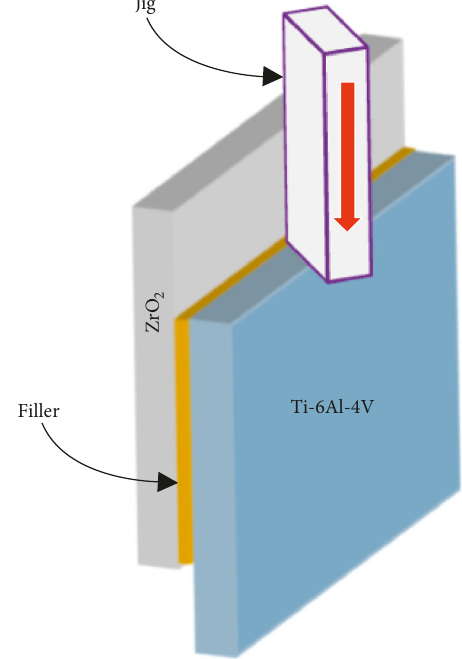
Figure 3: Schematic diagram for the shear